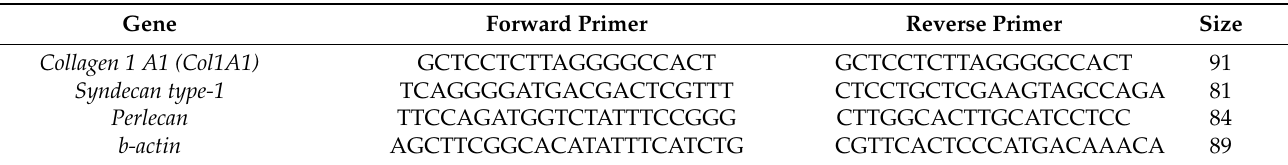
Table 1. List of used